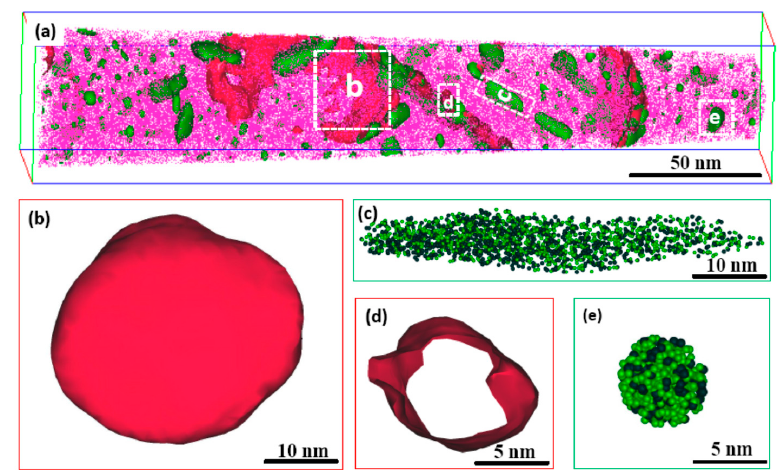
Figure 3. Morphology of precipitates observed by atom probe tomography (APT) analysis in PA-treated specimen. ( a ) 3-D reconstruction of the atomic positions of Fe ( pink points ), isoconcentration surface for regions containing more than 10 at % Mo ( red surfaces ) and 35 at % Ni + Ti (green surfaces); ( b ) Sphere-like Mo-rich phase outlined by 10 at % Mo isoconcentration surface; ( c ) Rod-like Ni 3 Ti phase outlined by Ni ( green ) and Ti ( grey ) atoms; ( d ) Flake-like Mo-rich phase outlined by 10 at % Mo isoconcentration surface; ( e ) Sphere-like Ni 3 Ti phase outlined by Ni ( green ) and Ti( grey ) atoms.